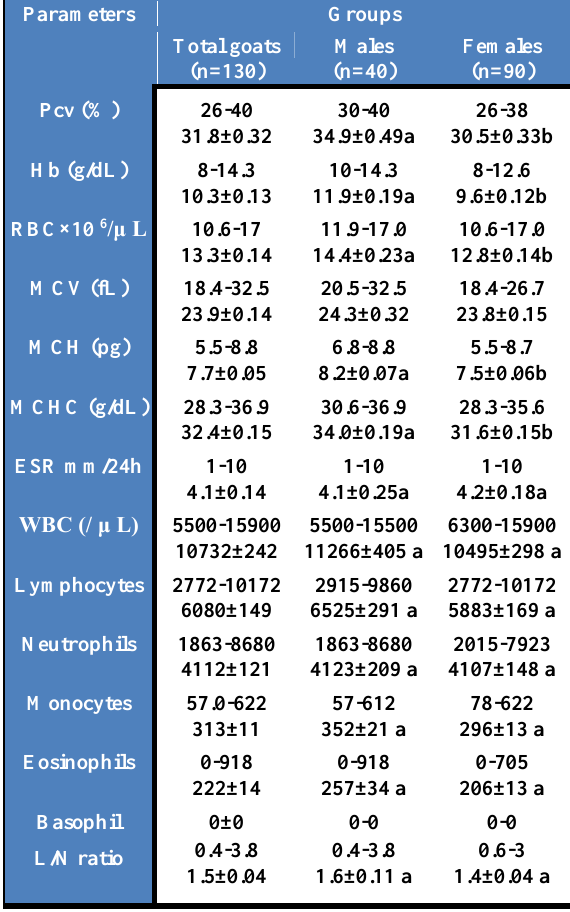
Table, 1: The hematological parameters for normal local breed goats; ranges and means+